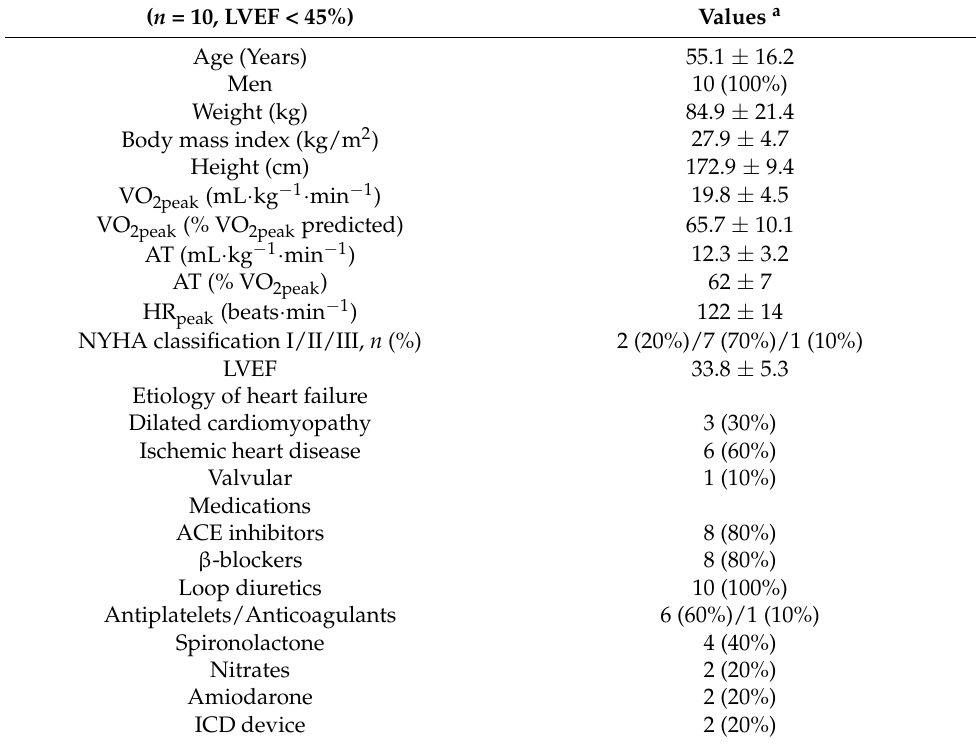
Table 1. Anthropometric, clinical and cardiopulmonary exercise testing